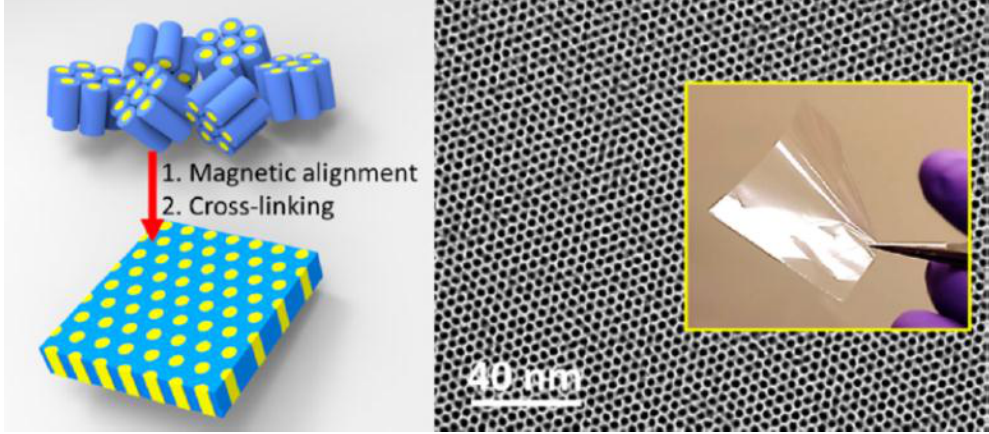
Figure 11. Prepared mesoporous membrane templated from hexagonal LLC and its TEM images after reorientation under a strong magnetic field [47] (Reprinted with permission from [47]. Copyright (2014) American Chemistry Society).